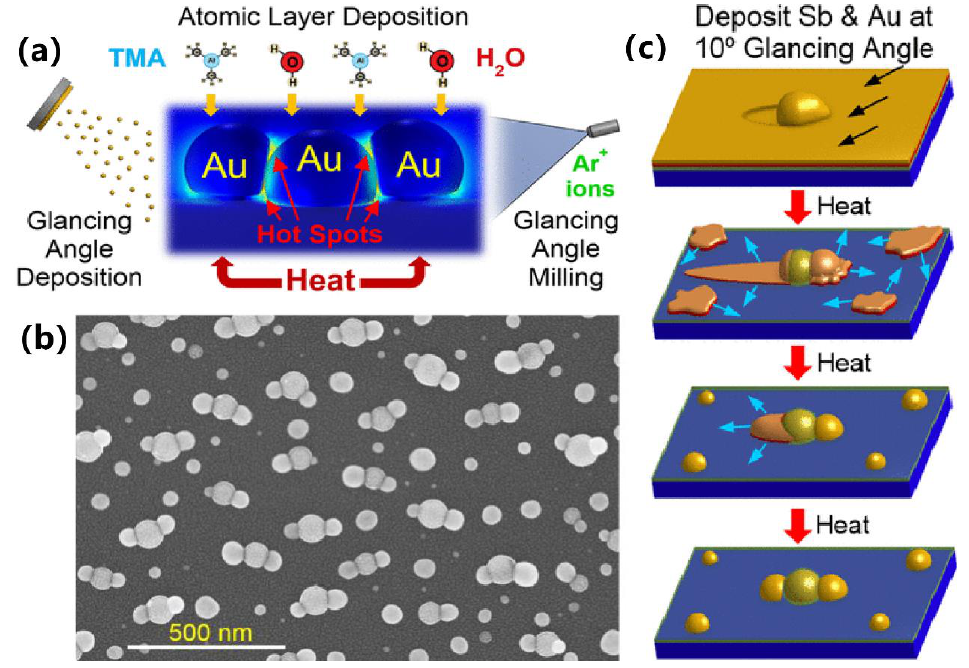
Figure 1. Plasmonic trimer structure based on nanoparticles and its synthesis process. ( a ) The abridged general view of the aligned trimers composed of Au nanostructures. ( b ) The SEM images of the assembled trimers. ( c ) The schematic diagram of manufacturing process. Reproduced with permission from reference [24]. Copyright 2022 American Chemical Society.